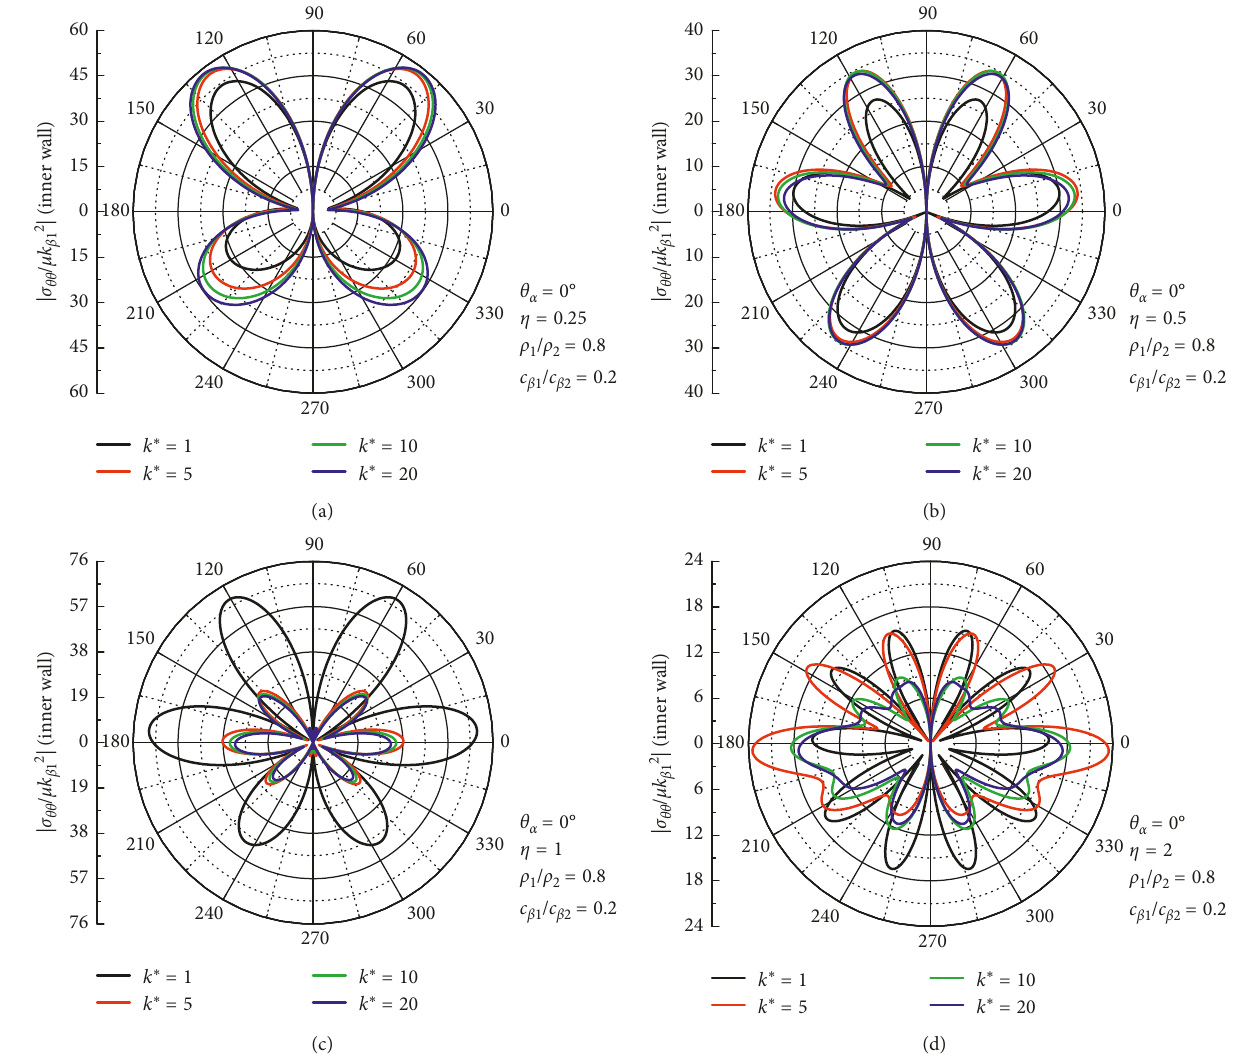
Figure 3: DSCF distribution on lining the inner wall under the incident SV wave ( θ